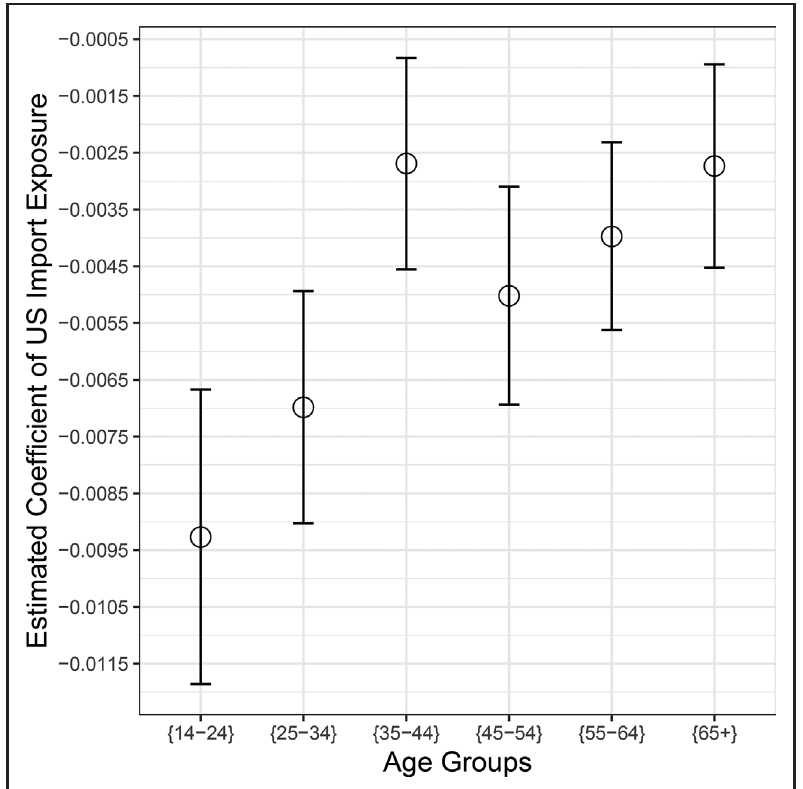
Estimated coefficients of import exposure by age group for 2000–2007. The graph shows the estimated coefficients and confidence intervals for US import trade exposure, in the simple specification that corresponds to columns 1 and 2 of Table 1. The estimates are constructed separately for each age group. T-tests of differences between the youngest age group and the others yield the